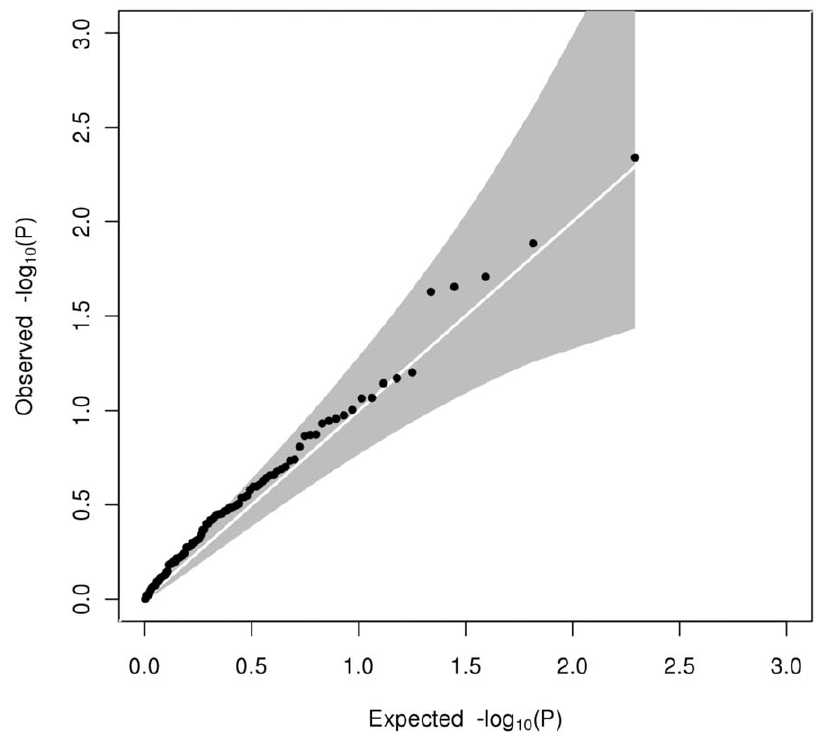
Figure 2. Quantile-quantile plot of observed against expected heterogeneity P-value for allelic associations with LDL-C. The grey shaded area represents the 95% confidence interval.